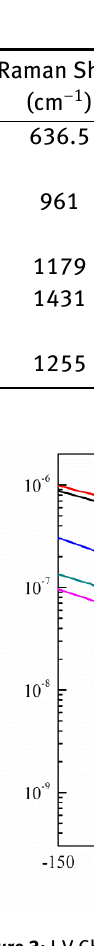
Figure 3: I-V Characteristic curves of pure PVC at different tempera-